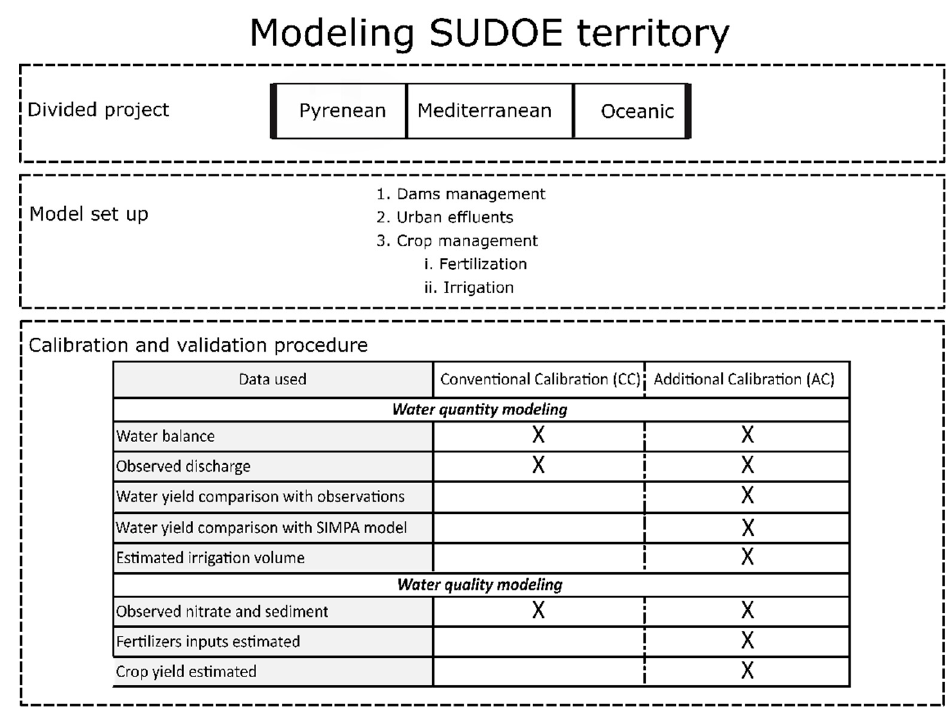
Figure 3. Global approach of this study to model SUDOE territory.